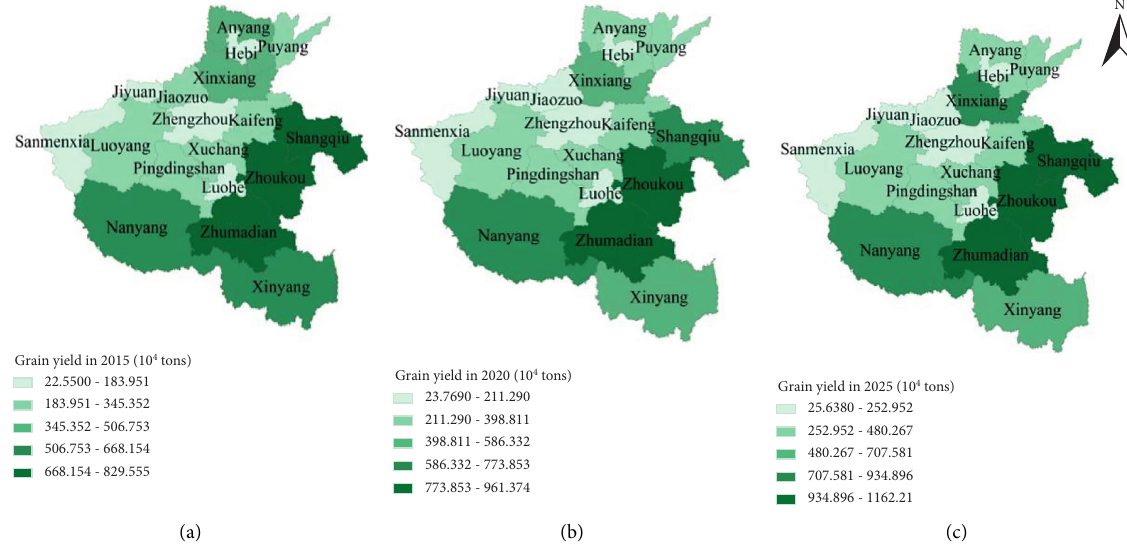
Figure 8: Spatial distribution of regional grain yield in Henan province. (a) Regional grain yield in 2015. (b) Regional grain yield in 2020. (c) Regional grain yield in